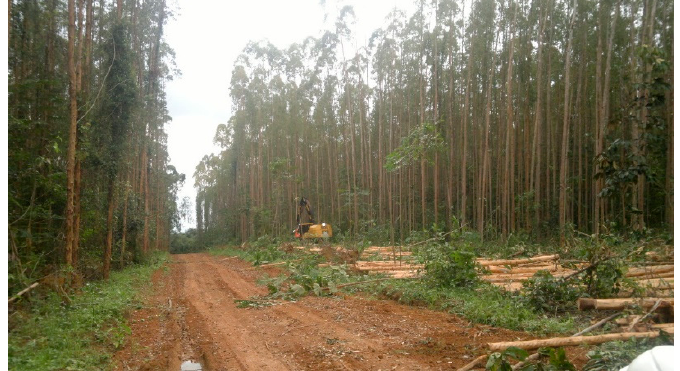
Figure 2. Image of the structure of Eucalyptus plantations in the study area. Table 1. Number of trees ( n ) and mean (and standard deviation) of diameter at breast height ( dbh ), h , and v per diameter